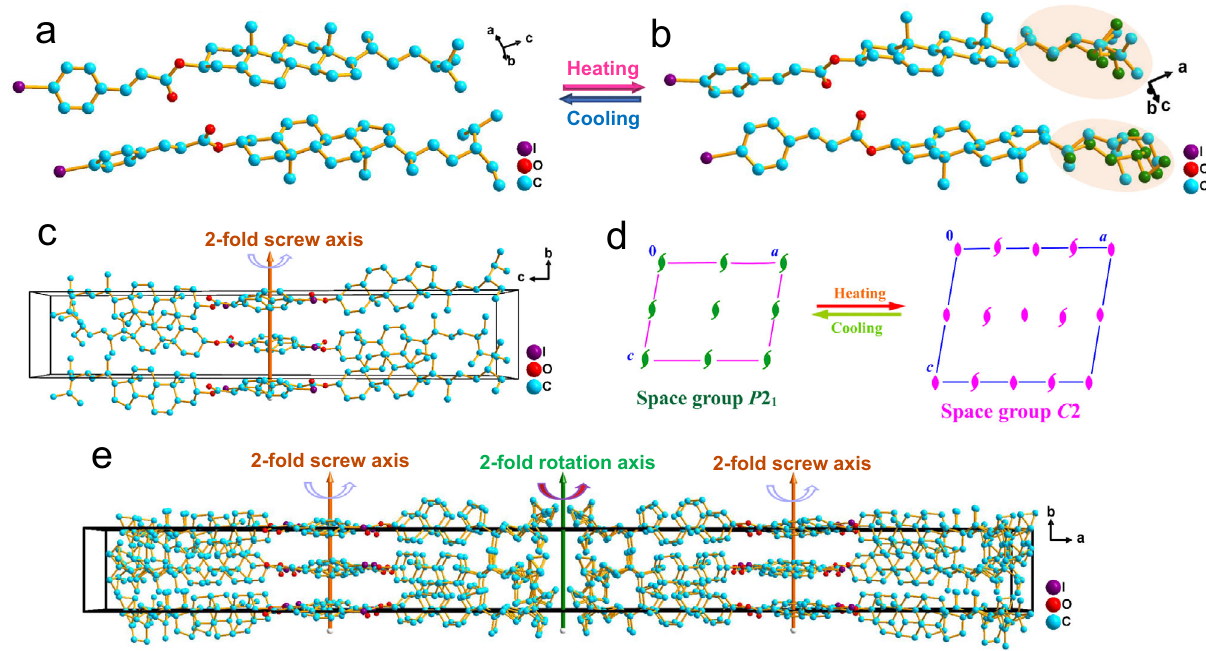
Fig. 2 | Crystal structures of 4I-CASS. a , b The asymmetric unit in phase I ( a ) and phase II ( b ), respectively. c Packing view in phase I along the [1 0 0] direction. d DiagramofthechangeinspatialsymmetryoperationsfromphaseItophaseII.In phase I, the green symbols stand for the symmetry operation of two-fold screw